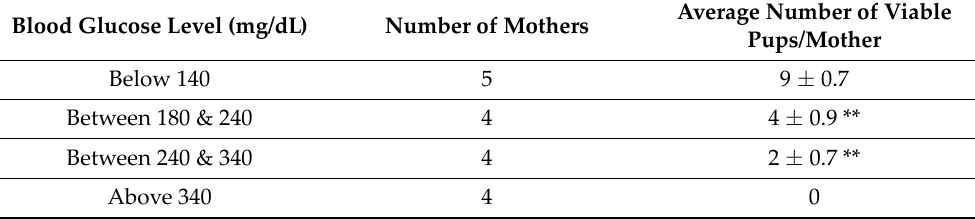
Table 1. Relationship Between the Mothers’ Blood Glucose Level and Average Number of Viable Pups. Blood Glucose Level